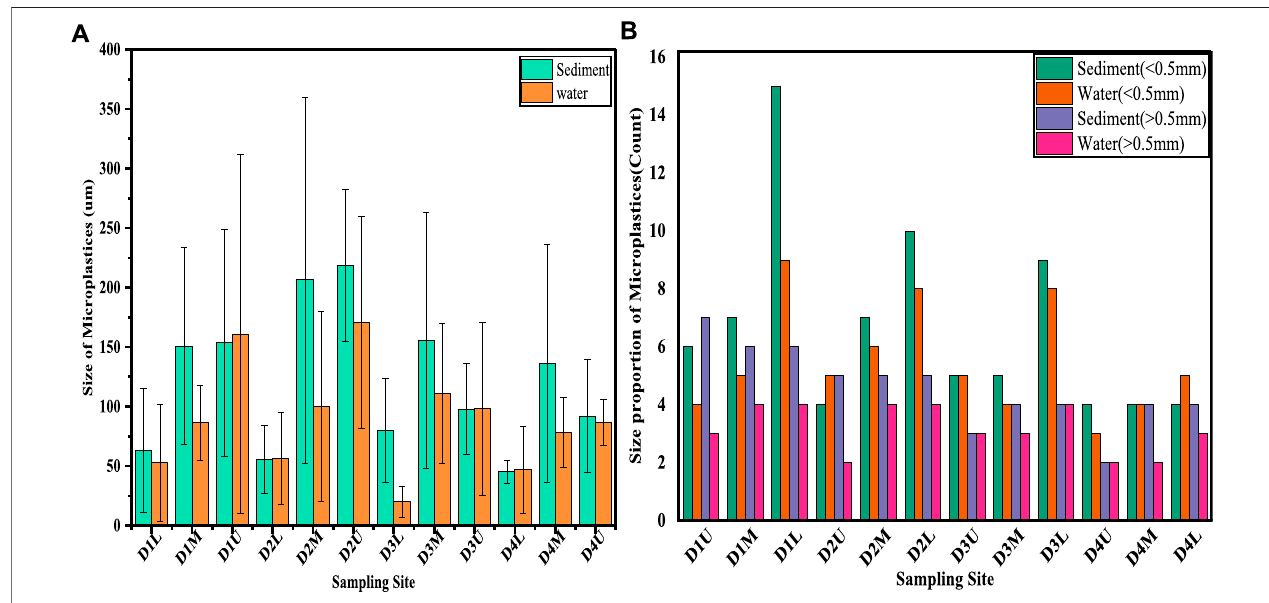
FIGURE3| Meansize(±SD)ofMPsinsedimentandagglomeratedsewagewatersamplesateachsamplinglocationforfourditches (A) 0.00417 – 0.5 mmand (B) proportion of MPs for large and small size particles.